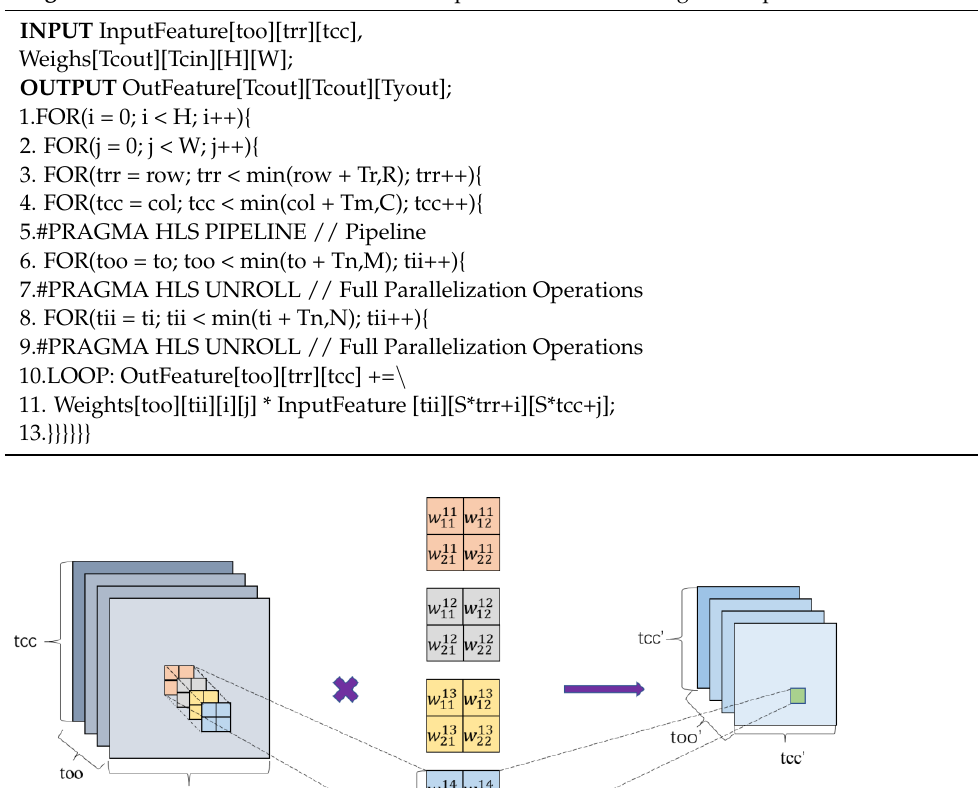
Figure 2. Overall architecture of CNN accelerator. Algorithm 1. Convolutional activation unit parallel acceleration algorithm pseudocode